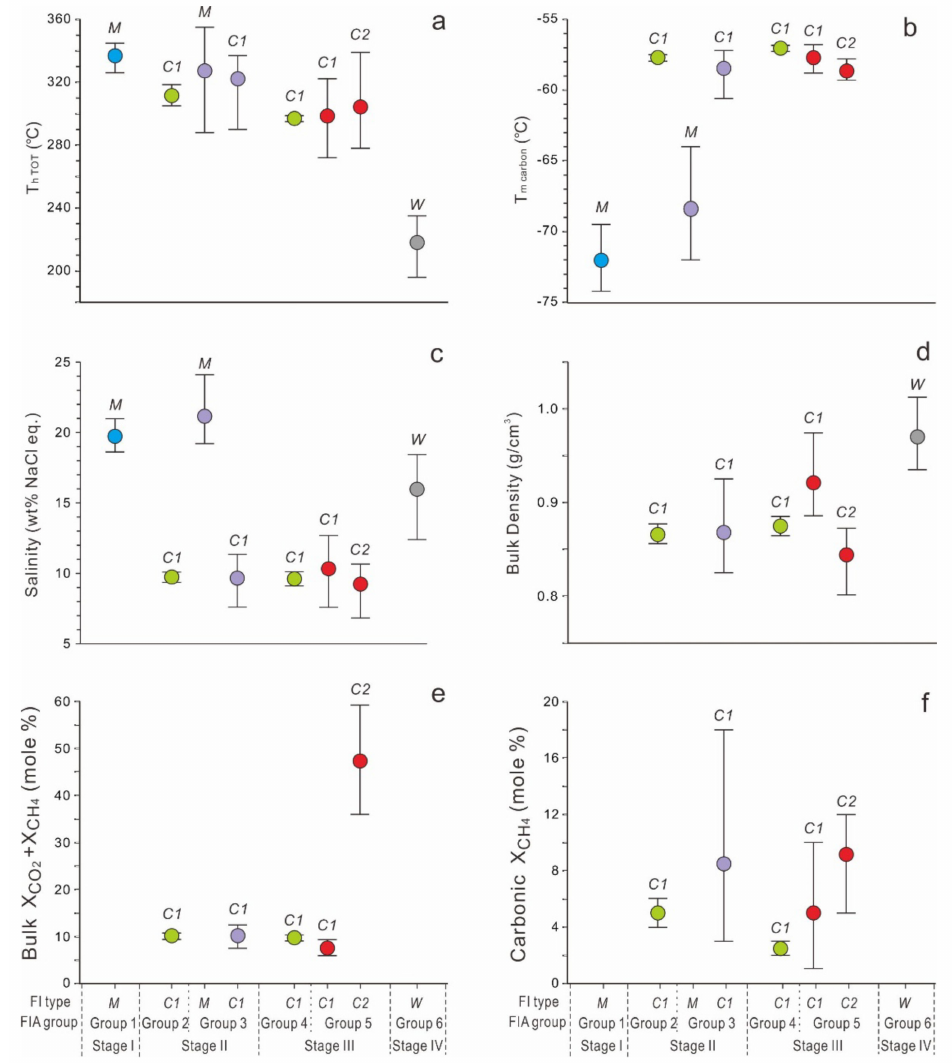
Figure 6. Ranges of T h TOT ( a ), T m carbon ( b ), salinity ( c ), bulk density ( d ), bulk X CO2 + X CH4 ( e ), and carbonic X CH4 ( f ) versus Groups 1–6 FIA in the four stages, respectively. The points in the middle of the bars are the mean